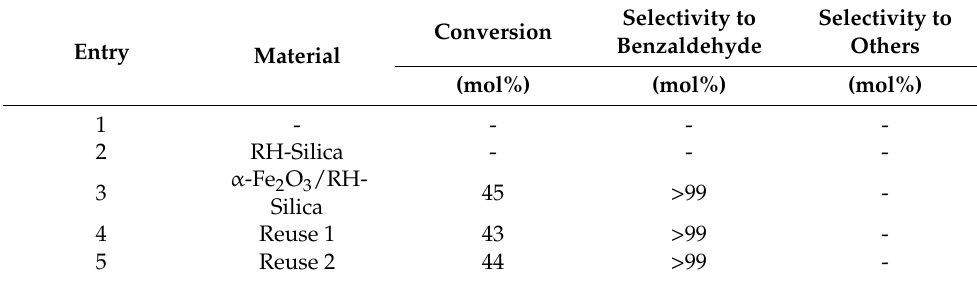
Table 2. Microwave-assisted oxidation of styrene using α -Fe 2 O 3 /RH-Silica as catalyst a . Entry Material